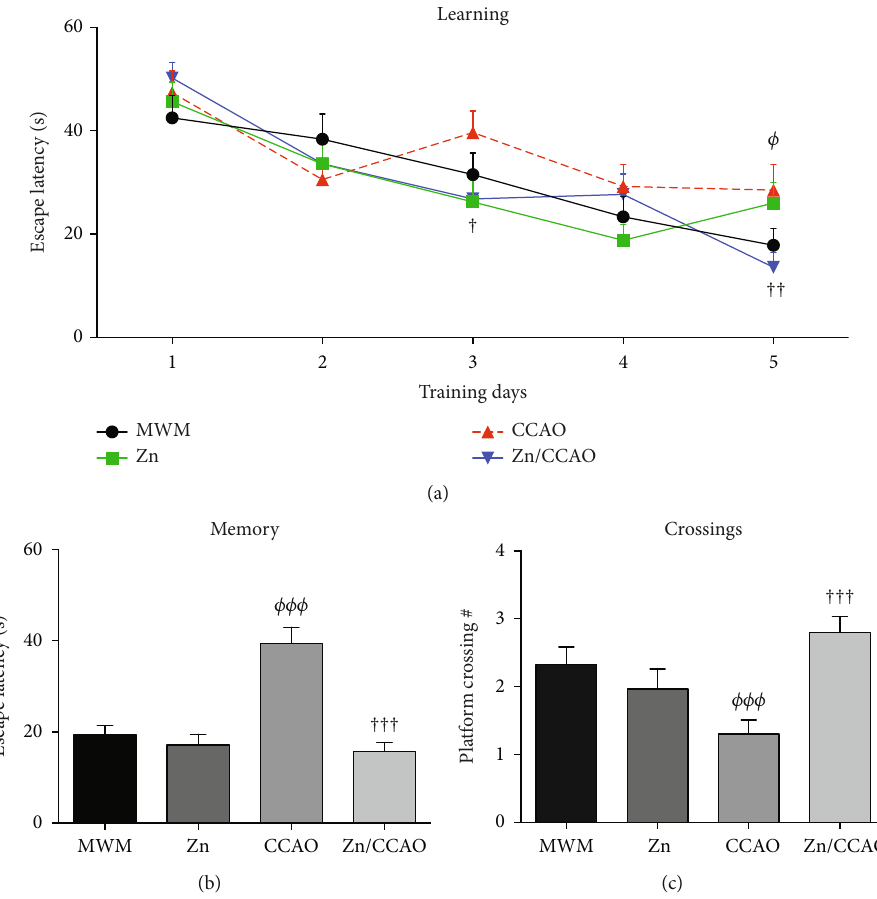
Figure 2: The subacute prophylactic zinc administration prevents the cognitive de fi cit caused by a 30min CCAO. The values are the mean ± SEM ( n = 21 to 30) and analyzed with two-way ANOVA and Bonferroni ’ s post hoc multiple comparisons. In addition, Kruskal- Wallis with Dunn ’ s post hoc test was used to analyze the escape latency in the memory test. P < 0 : 05 , Φ compared with the MWM group and † compared with the CCAO